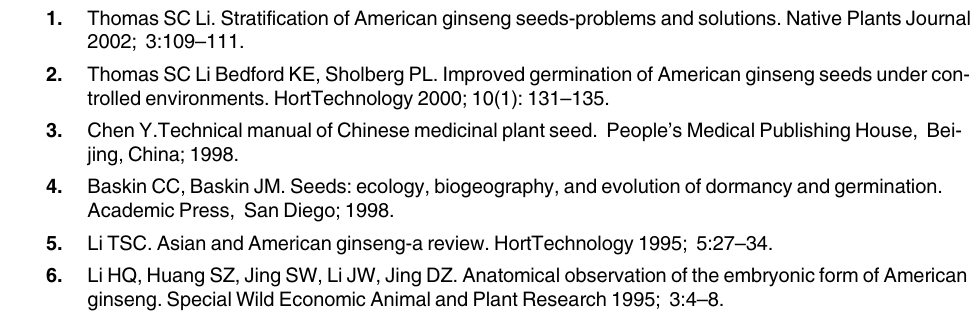
S1 Fig. Quality evaluation and saturation analysis of DGE sequencing of American ginseng embryos at different physiological stratification stages.